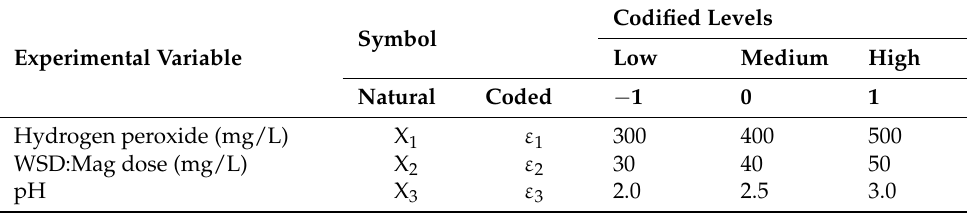
Table 1. Coded levels and independent variables used in Box–Behnken design.